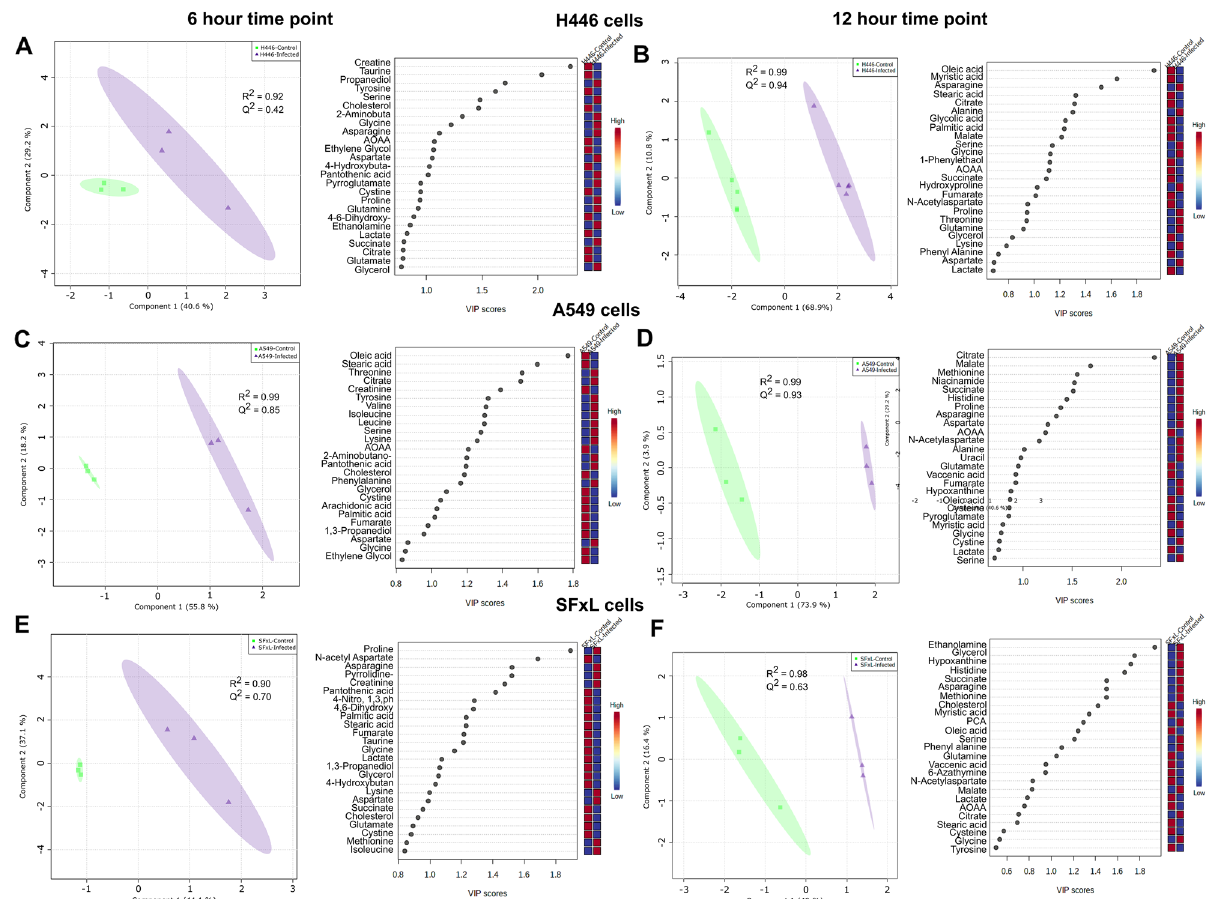
Figure 3. Supervised PLS-DA of control and infected cells: 2D scores plots of PLS-DA and VIP plots for three cancer cell lines at 6 h and 12 h post infection—( A , B ) H446 cells, ( C , D ) A549 cells and ( E , F ) SFxL cells. The explained variance for components 1 and 2 are displayed in parentheses on each axis. The shaded areas reflect the 95% confidence regions based on the data points for each group in PLS-DA models. VIP scores plots from the PLS-DA demonstrating the differences in the level of top 25 cellular metabolites between control and infected cancer cells. Abbreviations: AOAA: (Aminooxy)acetic acid, P.C.A.: pyrrolidine 1,2-carboxylic